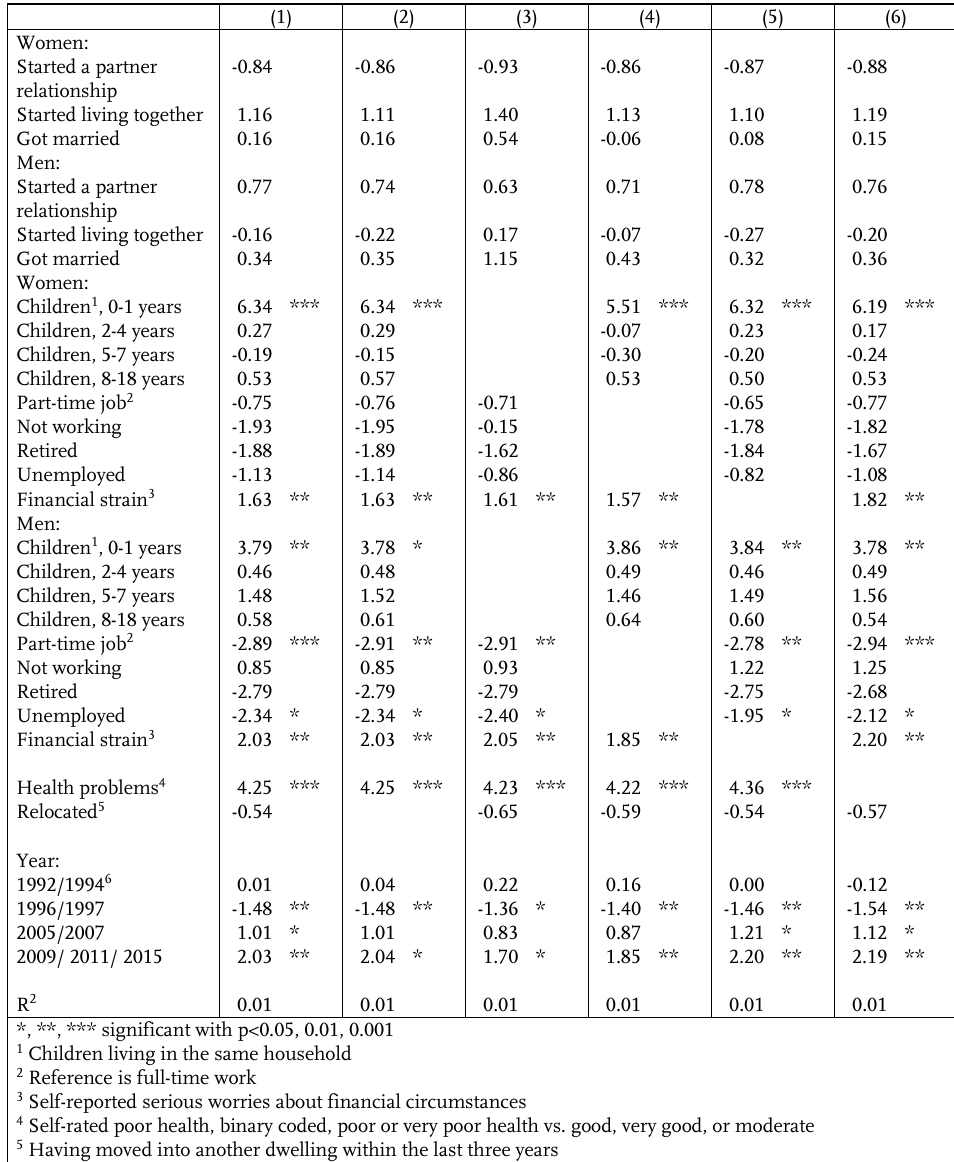
Table A.3 : Effects of partner relationships, children, employment, relocations, health and financial strain on absence of tertiary-sphere contacts (non-participation in clubs and civil organizations; linear- probability models with fixed effects, percentage